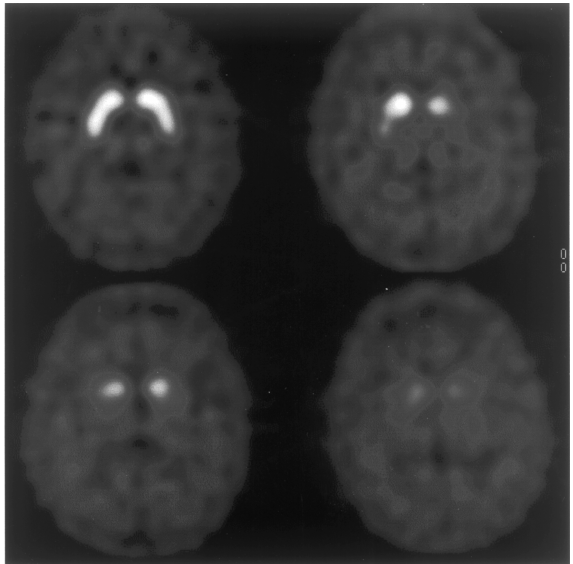
Fig.3. SPECTimages of [ 123 I]FP-CIT binding to dopamine transporters in anormal healthy control subject (top left) and patients at progressively more severe stages of PD (image courtesy of Dr. Jim Patterson, Institute of Neurological Sciences,